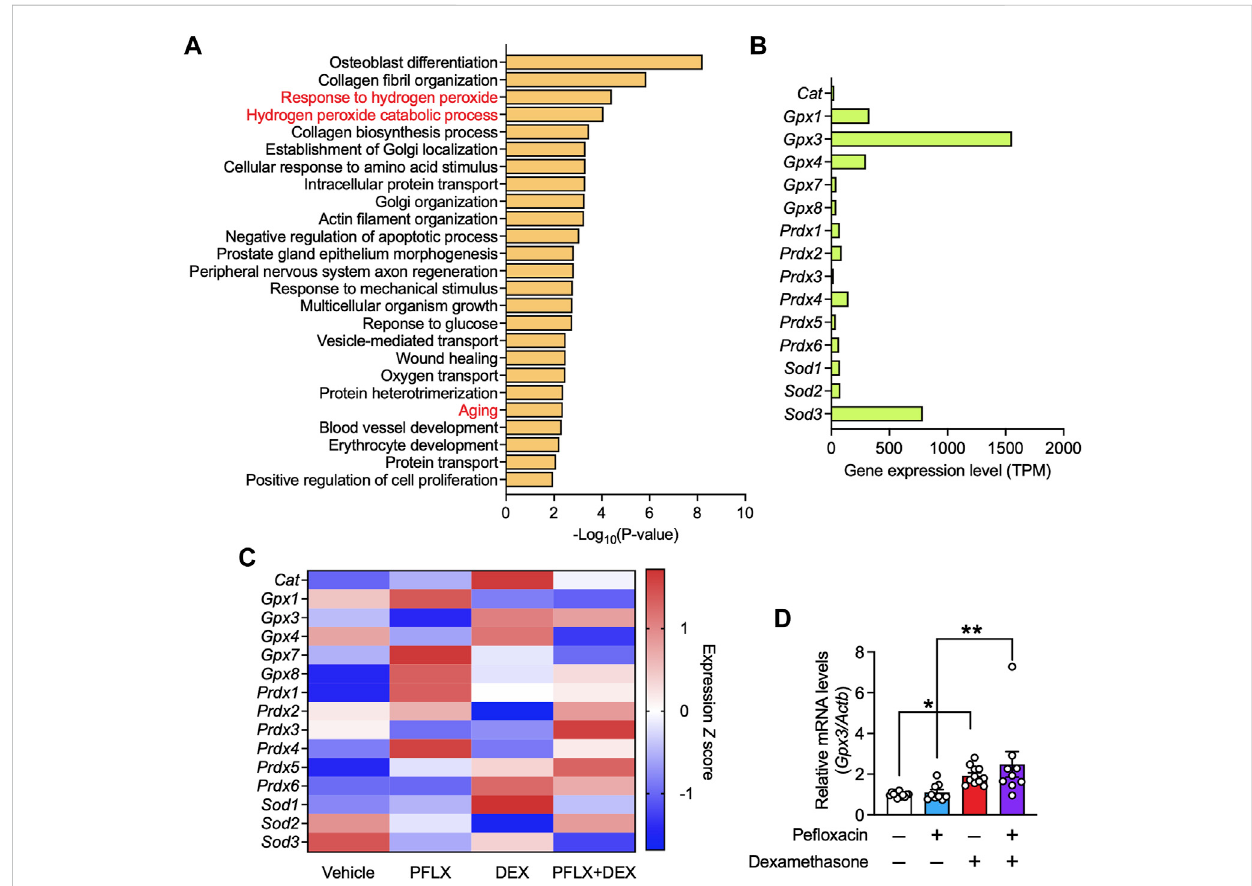
FIGURE 5 Gene expression in the tendon tissues of rats treated with pe fl oxacin, dexamethasone, or both. (A) Gene ontology (GO) analysis of genes whose expression, with transcripts per million (TPM) ≥ 100 in the vehicle group, was increased in the pe fl oxacin group compared with that in the vehicle group and reduced in the group administered both pe fl oxacin and dexamethasone compared with that in the pe fl oxacin group. The top 25 signi fi cantly enriched GO termsare shown. (B) The relative gene expressionlevels, shownas TPM, ofantioxidant enzymesin theAchilles tendon from avehicle- administered rat. (C) Heatmap of gene expression of antioxidant enzymes in Achilles tendon from rats administered vehicle, pe fl oxacin (PFLX), dexamethasone (DEX), or both (PFLX + DEX). Red and blue colors represent large and small standardized values in Z scores, respectively. (D) The gene expression of Gpx3 was examined using quantitative RT-PCR ( n = 9 – 12 per group) and represented as the relative ratio to the control group. Data are shown as the mean ± SEM. Statistical signi fi cance was tested using a two-way ANOVA with post hoc multiple comparisons; * p < 0.05, ** p <